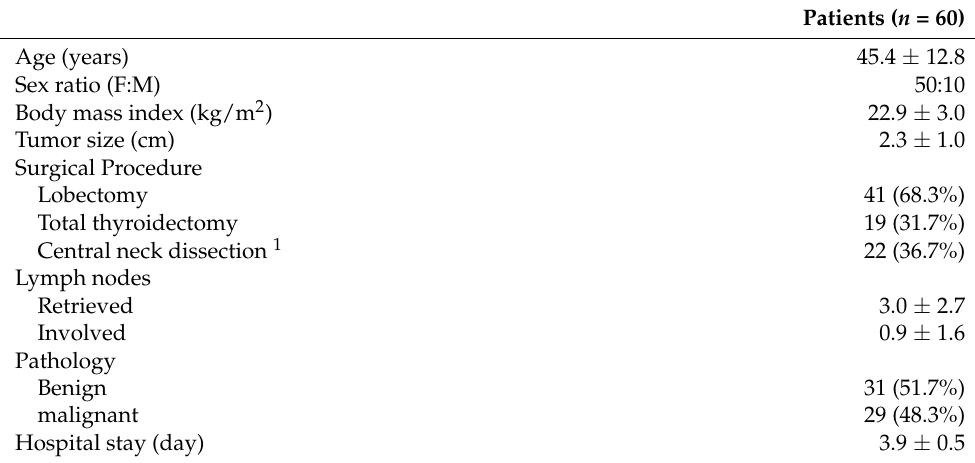
Table 1. Demographic and clinical characteristics of